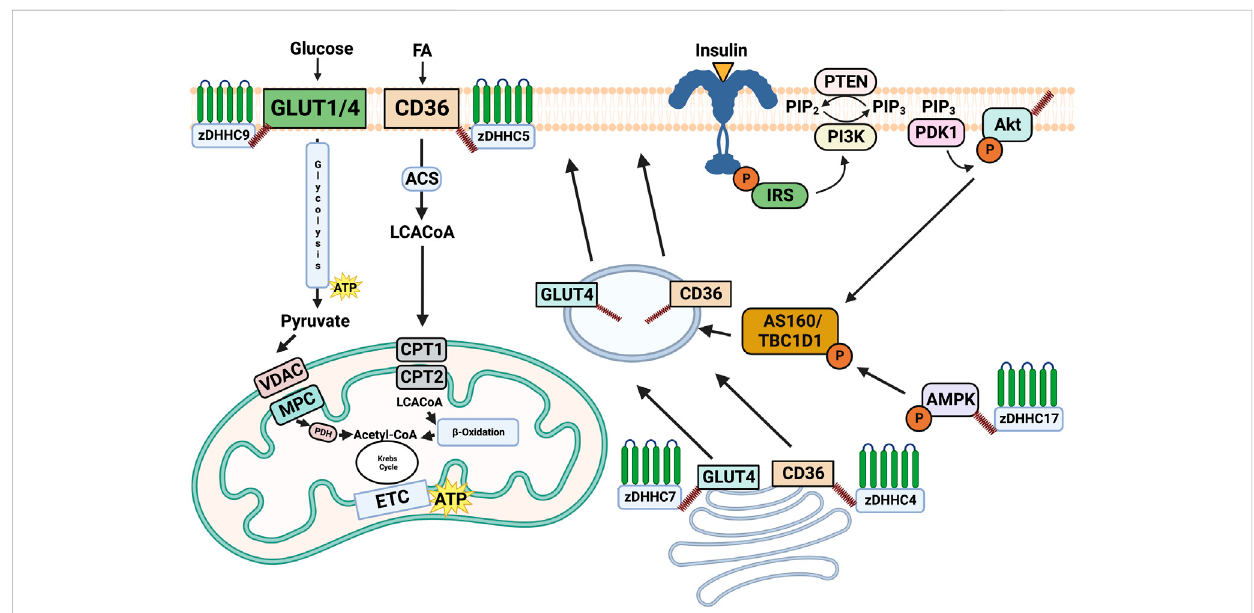
FIGURE 1 Overview of the role of palmitoylation in regulating substrate metabolism. Palmitoylation of CD36 and GLUT4 by DHHC4 and DHHC7, respectively induces their traf fi cking to the plasma membrane. Once on the plasma membrane DHHC5 palmitoylates and stabilizes CD36, while zDHHC9 palmitoylates GLUT1. Subcellular traf fi cking and maintenance on the plasma membrane driven by palmitoylation subsequently results in the uptake of fatty acids and glucose from CD36 and GLUT4/1. Palmitoylation of AMPK α by DHHC17 has been shown to be required for its phosphorylation and localization, while Akt palmitoylation by an unknown DHHC is required for its phosphorylation. While AMPK α and Akt are important modulators of substrate metabolism, the downstream consequences of their palmitoylation remain unknown. Made on